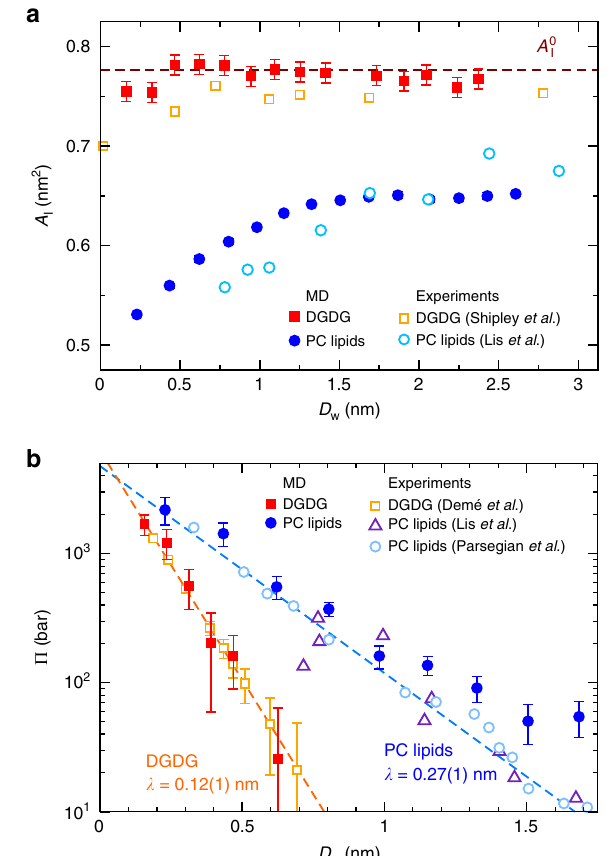
Figure 2 | Comparison between experiments and simulations. ( a ) Area per DGDG and PC lipid headgroup as functions of the water layer thickness D w . Filled symbols indicate simulation results obtained with DGDG and with the PC lipid DLPC with semi-isotropic pressure coupling. Open symbols indicate experimental results for DGDG 25 and DLPC 16 membranes. Error bars for the simulation data represent 1 s.d. of uncertainty and were estimated from the scatter of the points around the plateau value at high hydration. For DLPC, they are smaller than the size of the symbols. The experimental error can be estimated in the same way as r 0.02nm 2 . ( b ) Pressure–distance curves of DGDG 14 and PC lipid membranes 16,28 as obtained in experiments (open symbols) and in the present simulations (filled symbols). Straight dashed lines in the semi-logarithmic plots indicate the best-matching exponential fits to the experimental data points for DGDG 14 and to the combined experimental data sets for egg PC 28 and DLPC 16 . Error bars represent 1 s.d. of